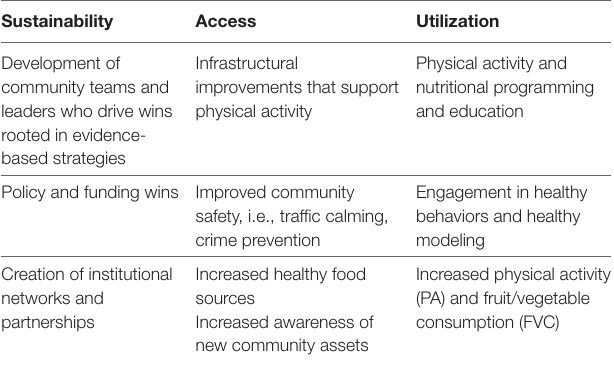
taBlE 1 | Implementation outcome categories targeted by